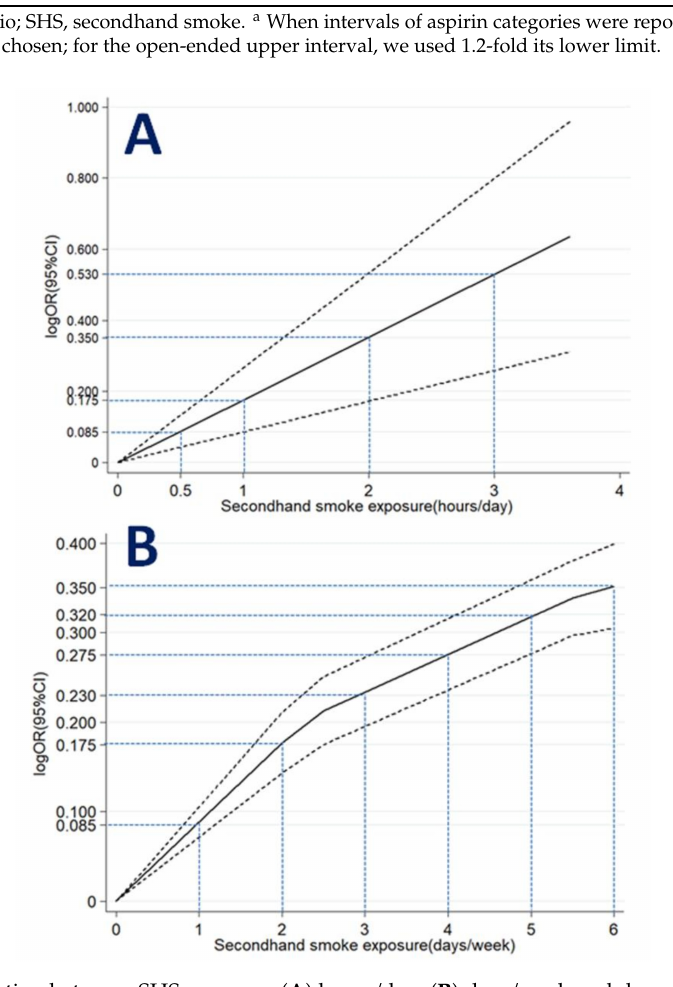
Figure 4. Association between SHS exposure ( A ) hours / day; ( B ) days / week and depressive symptoms obtained by dose–response meta-analyses. Solid line represents the estimated odds ratio and the dot-dashed lines represent the 95% confidence